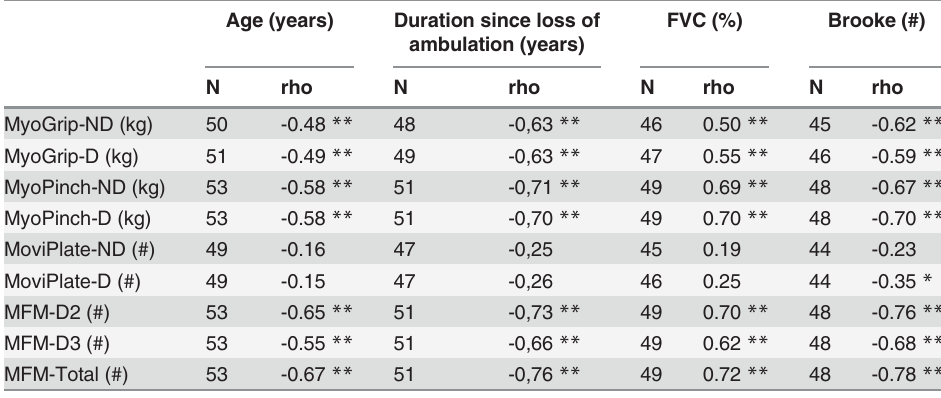
Table 4. Correlation between the MyoSet and MFM at baseline on dominant (D) and non-dominant (ND) sides with clinical and motor function